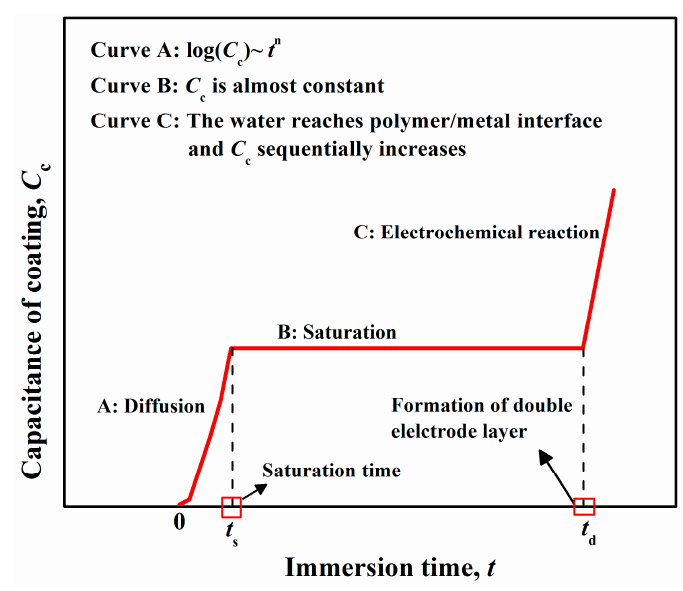
Figure 2. Change in polymer capacitance caused by water diffusion over time.